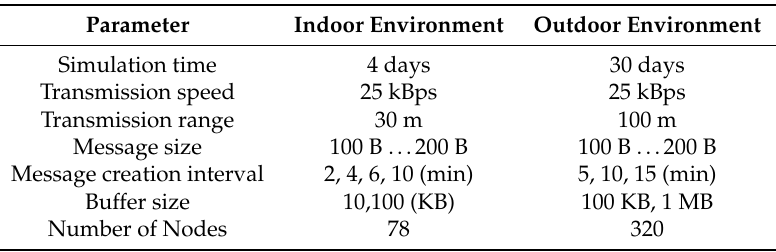
Table 3. Simulation